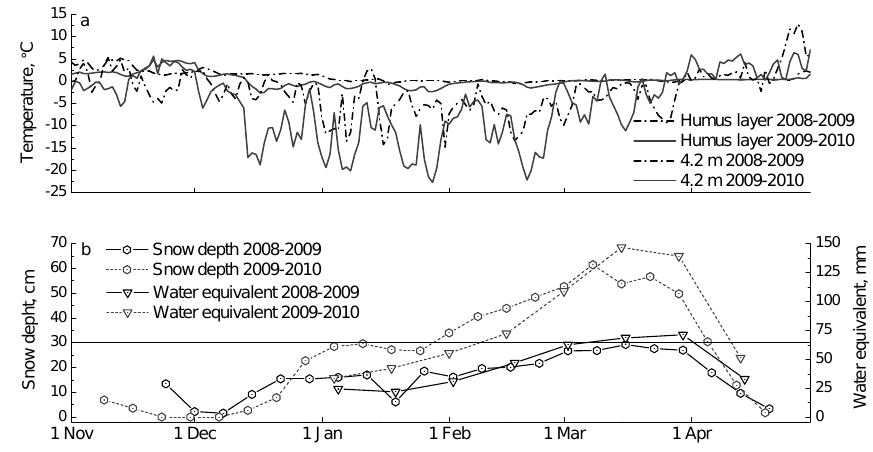
Fig. 2. Temperature, snow depth and water equivalent at the SMEAR II station during winters 2008–2009 and 2009–2010. (a) temperature in humus layer and at 4.2-m height, (b) snow depth and water equivalent. Horizontal line in panel (b) shows the height of the uppermost collectors.